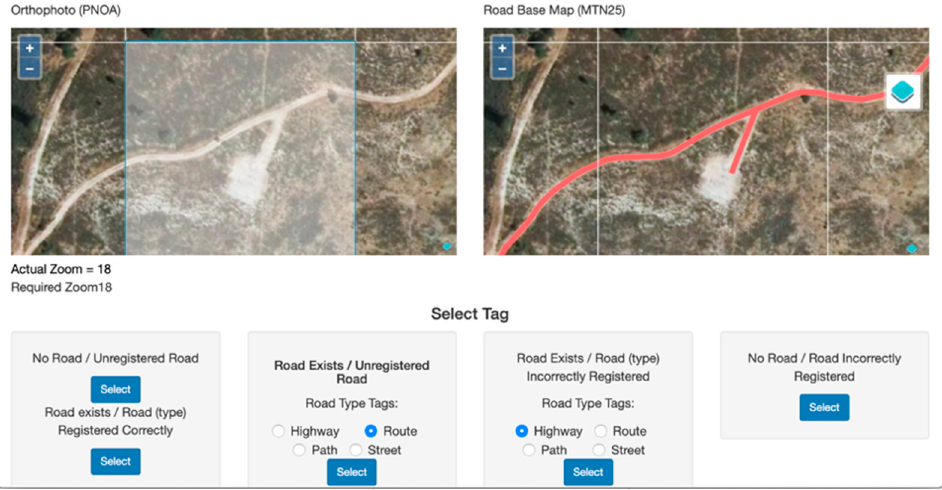
Figure 1. Data collection web